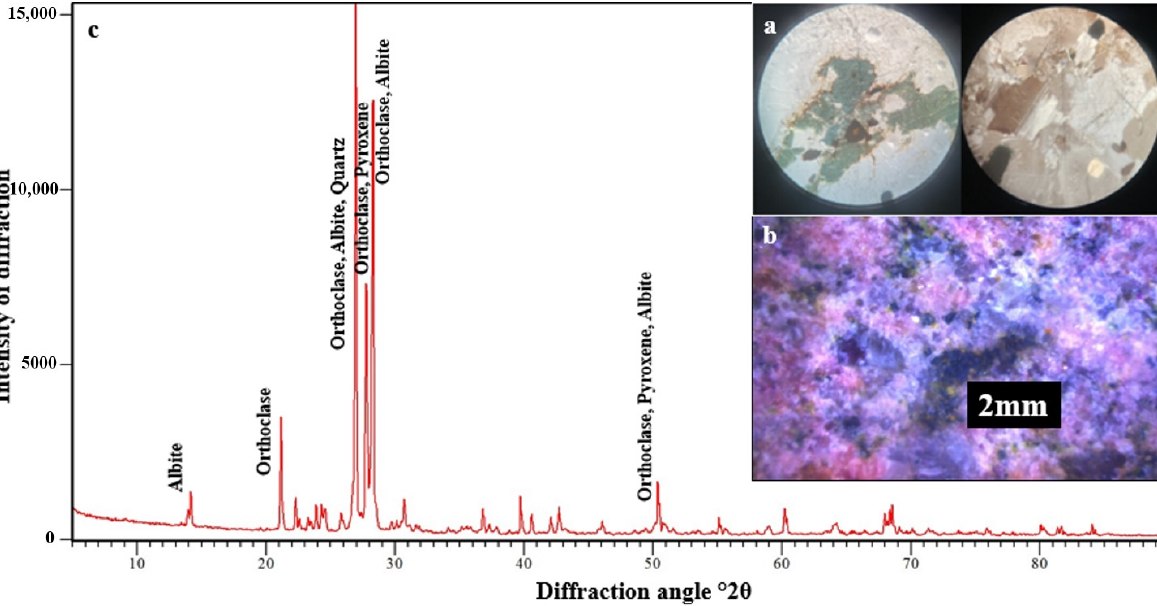
Figure 11. ( a ) Petrographic thin section; ( b ) SEM micrograph, and ( c ) XRD of gneissic rock sample from the study area.